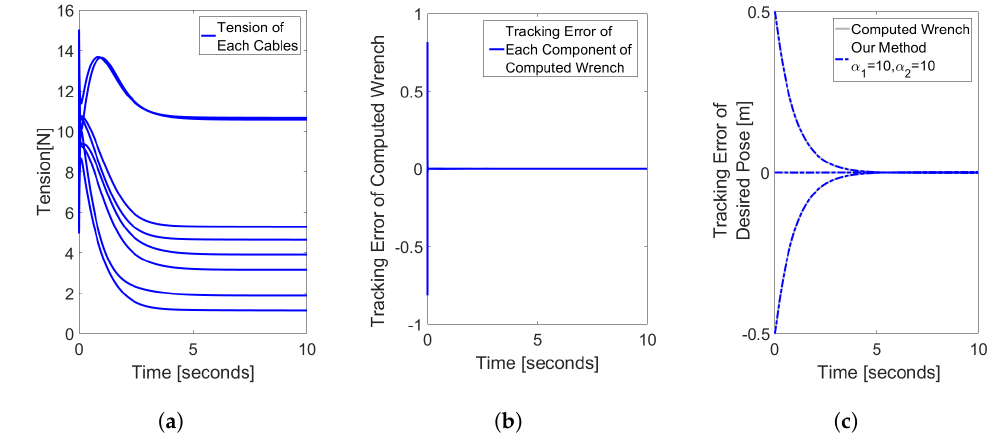
Figure 5. Results of Simulation 2. Parameters and desired pose are selected as α 1 = 15 , α 2 = 12, K d = 10, D d = 10, K i = 0.1, q d = [ 0.6, − 0.6,0.6,0,0,0 ] T . ( a ) Tension distribution in Simulation 2. ( b ) Tracking error ofcomputed wrench. ( c ) Tracking error of desired